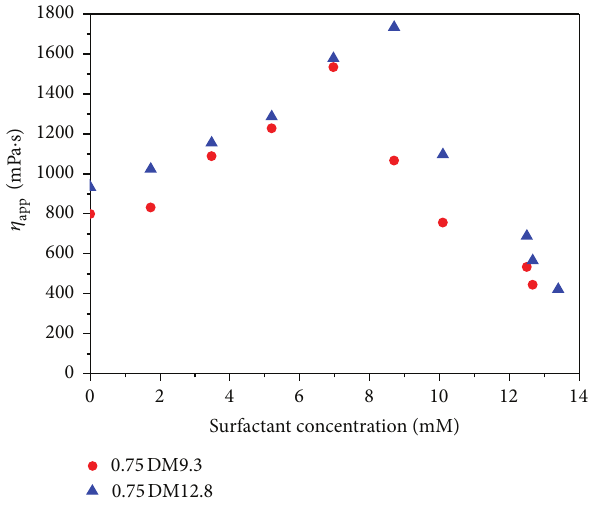
Figure13:Fluorescencespectraofpyrenein0.25 gdL −1 0.75DM12.8 solutions at different